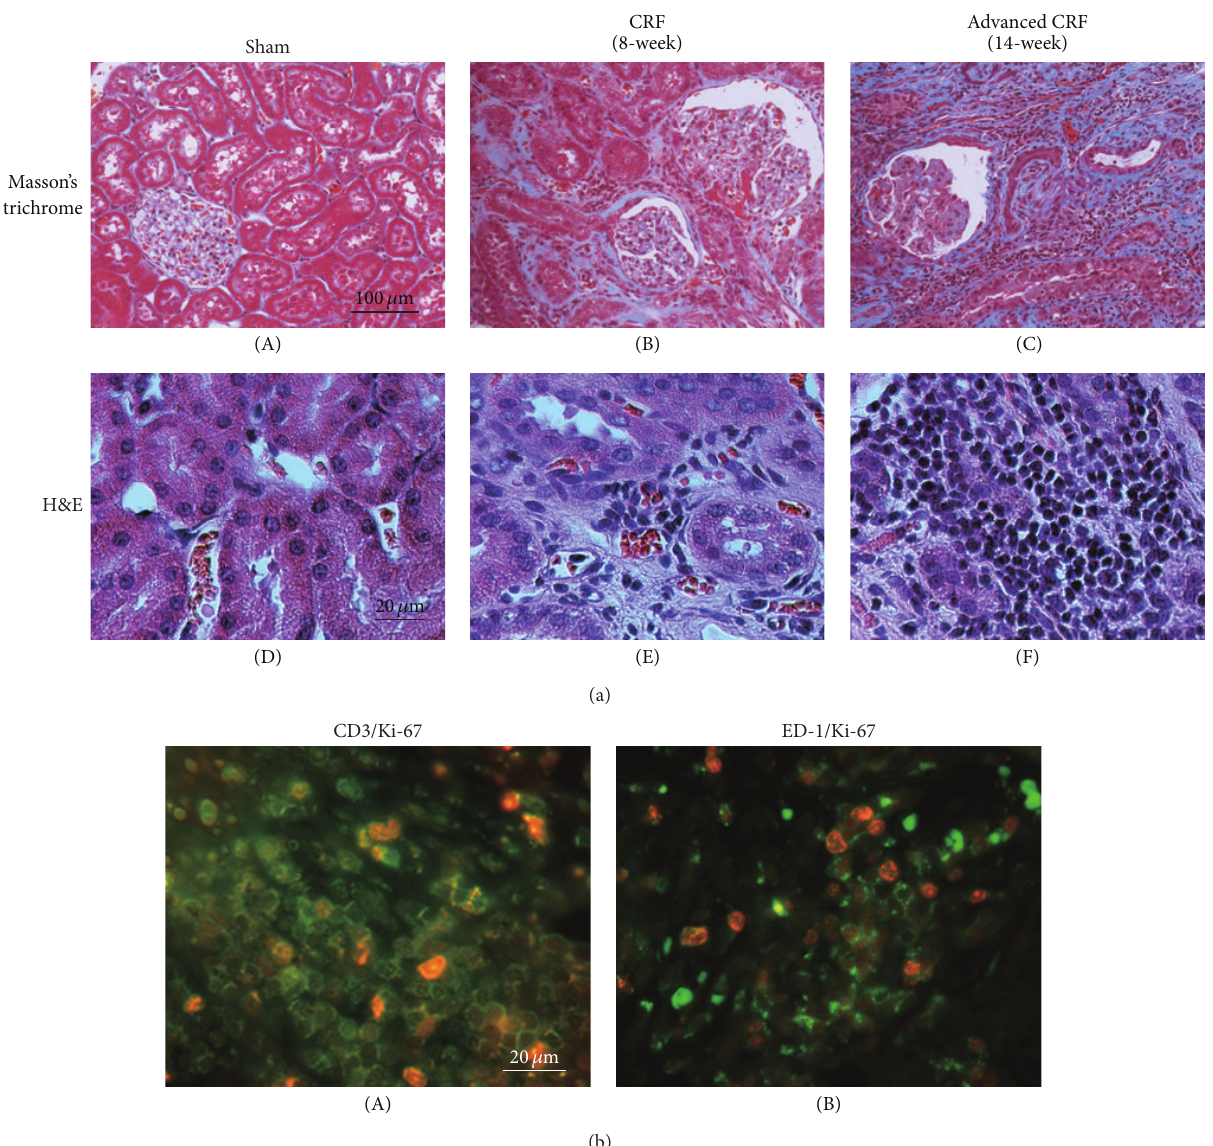
Figure 2: Histological features of sham-operated (sham), CRF, and advanced CRF rat kidneys. (a) Hematoxylin and eosin (H&E) and Masson’s trichrome staining, in sham-operated (sham), CRF (8 weeks after nephrectomy), and advanced CRF (14 weeks after nephrectomy) rat kidneys. ((A), (B), and (C)) Low-power views of cortex, Masson’s trichrome. Magnification, × 20. ((D), (E), and (F)) High-power views of cortical interstitium, H&E. Magnification, × 60. (b) Immunofluorescence staining using antibodies for CD3 ((A) green) and ED-1 ((B) green), costained with Ki-67 (red) in advanced CRF rat kidneys. High-power views of the cortical interstitium. Magnification, × 60. Modified from